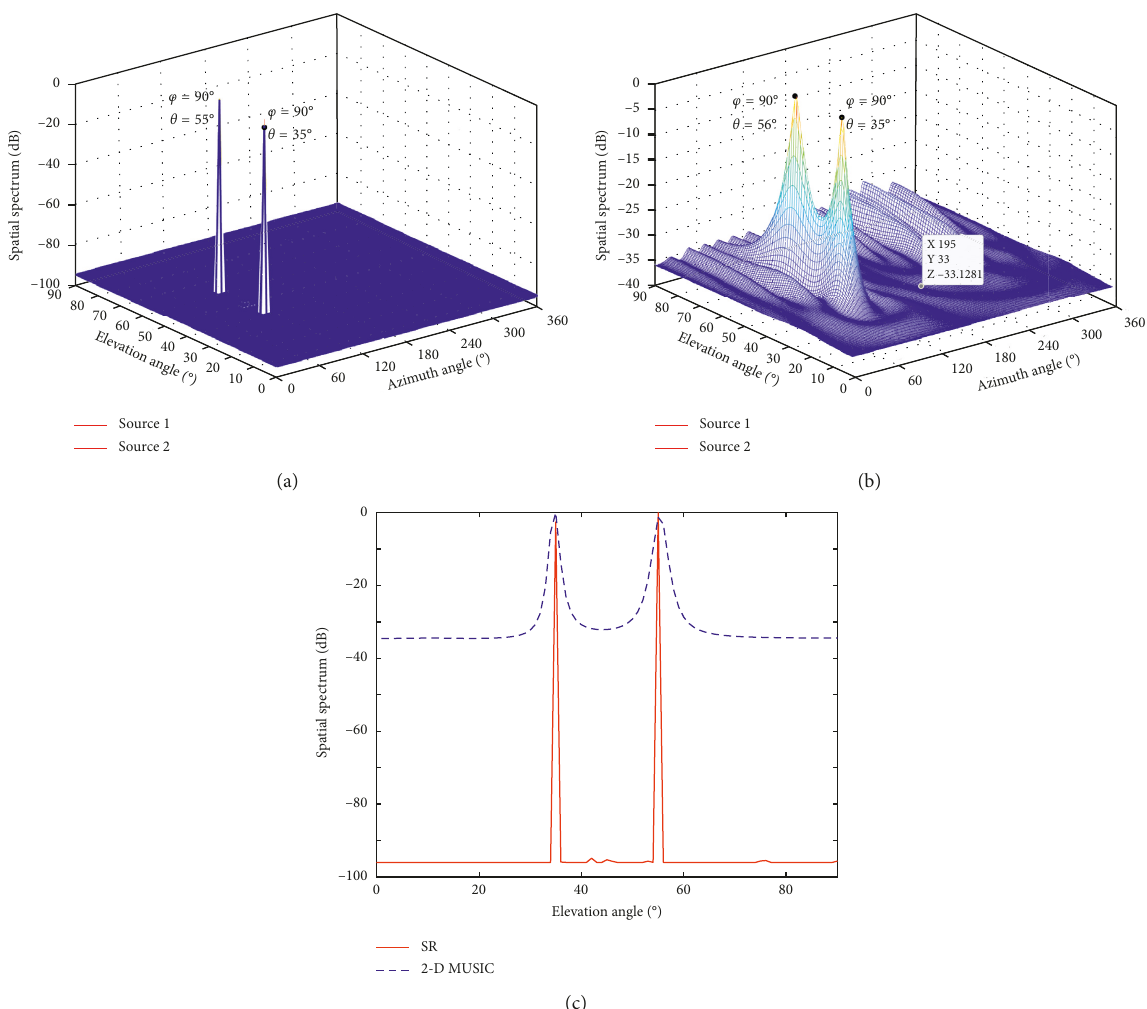
Figure 3: The comparison of incoherent source spectrum (SNR � 0dB). (a) Spatial spectrum by SR method. (b) Spatial spectrum by standard 2D MUSIC method. (c) Elevation angle spectrum ( φ � 90 °